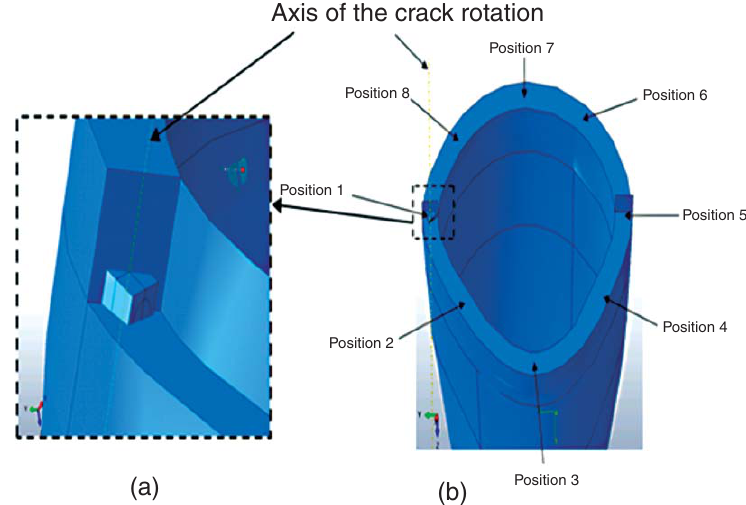
Fig. 6. (a) Close-up the crack submodel in the cement mantle and (b) the crack positions.